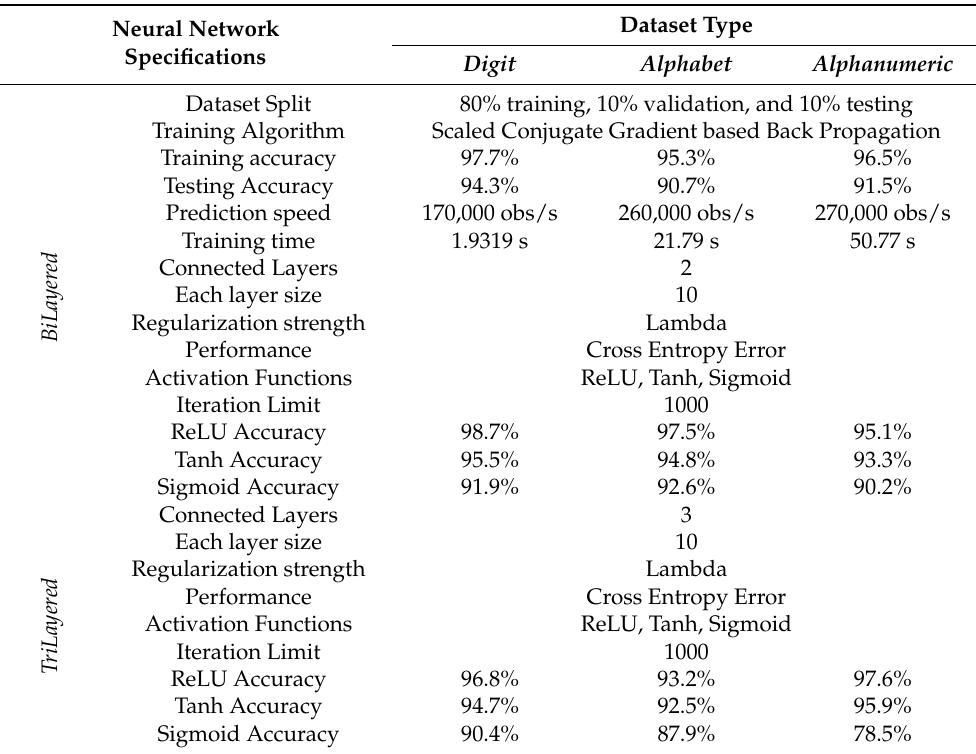
Table 1. Statistical information of different variants of neural models on digit, alphabetic, and alphanumeric